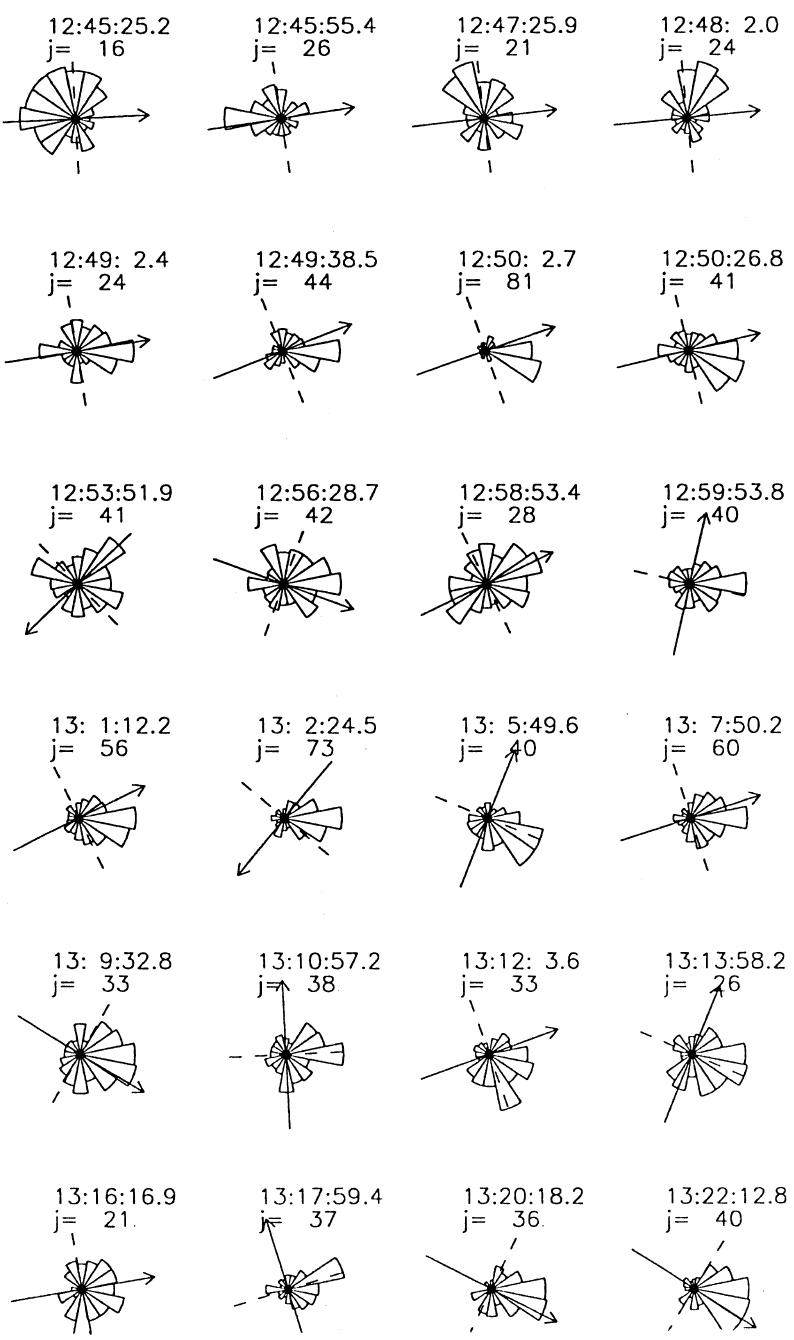
Fig. 7. The angular distributions of ions with energies between 62 and 74 keV, during the burst of March 31, 1993, that occurred between 1245 and 1325 UT. The equatorial projection of the magnetic field is overplotted. The data are plotted versus viewing direction. The Sun lies to the right of